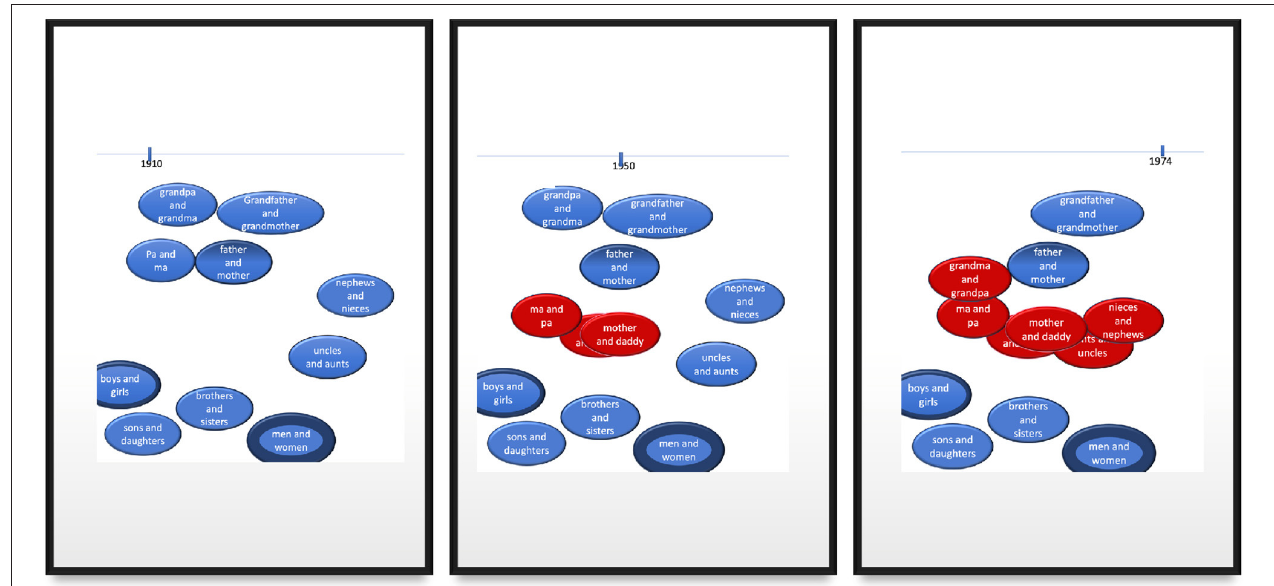
FIGURE 6 | The three panels capture simplified snapshots of historical change for a handful of representative items. Blue circles represent a bias toward male-first order, while red circles represent a bias for female-first order. The thickness of the circles indicates their relative token frequencies (in either